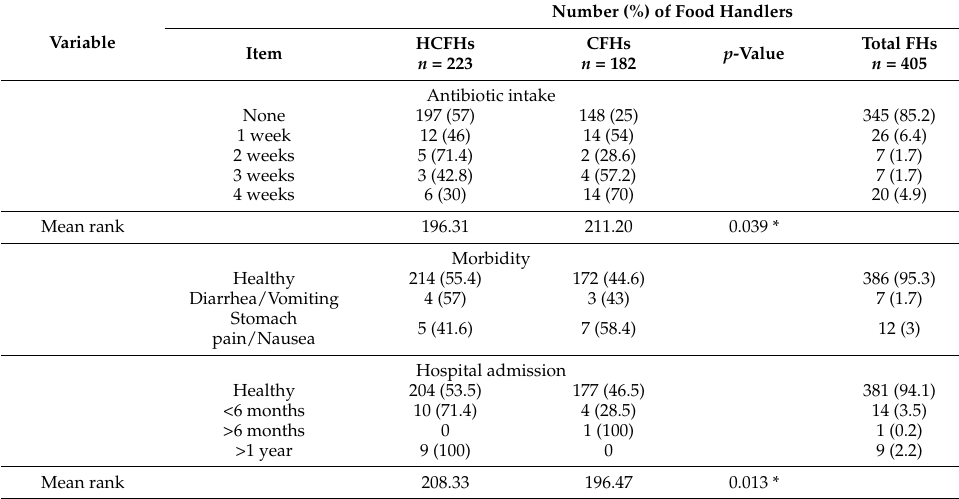
Table 4. Risk factors among healthcare and community food